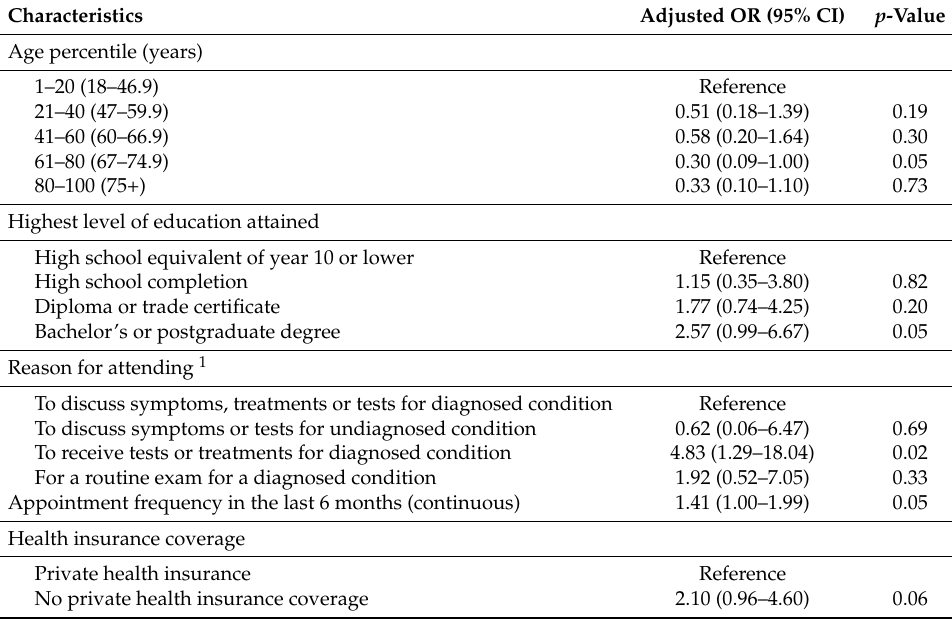
Table 8. Adjusted odds of selecting “Improved hospital